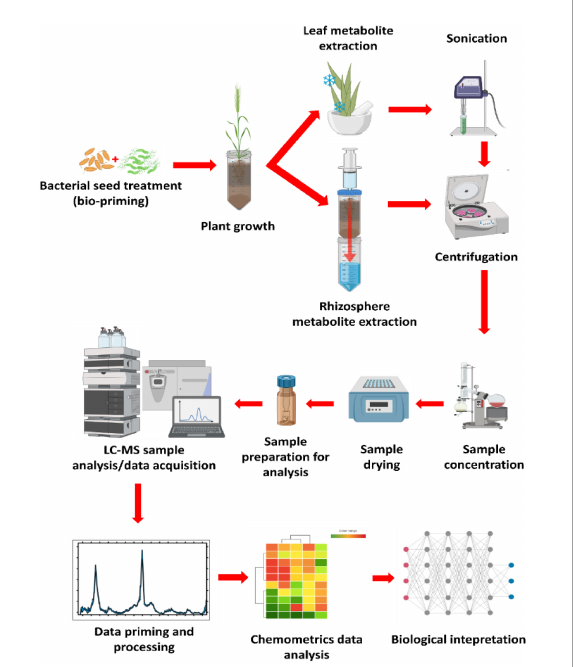
FIGURE1 General experimental design and metabolomics workflow. The diagram above illustrates the basic experimental design utilized in the current study for the rhizosphere metabolite profiling after the seeds of the crop of interest were treated with strains of plant growth-promoting rhizobacteria (PGPR; bioprimed). The plants were grown in perforated conical centrifuge tubes. Metabolite extraction was carried out by pressurizing the extraction solvent (80% methanol) through the growth medium (rhizosphere) and collected in a clean centrifuge tube.